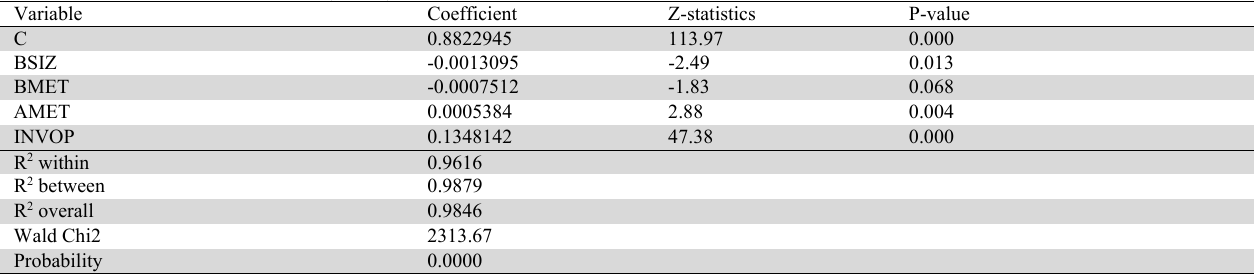
Results of Random Effect Model (REM) Variable